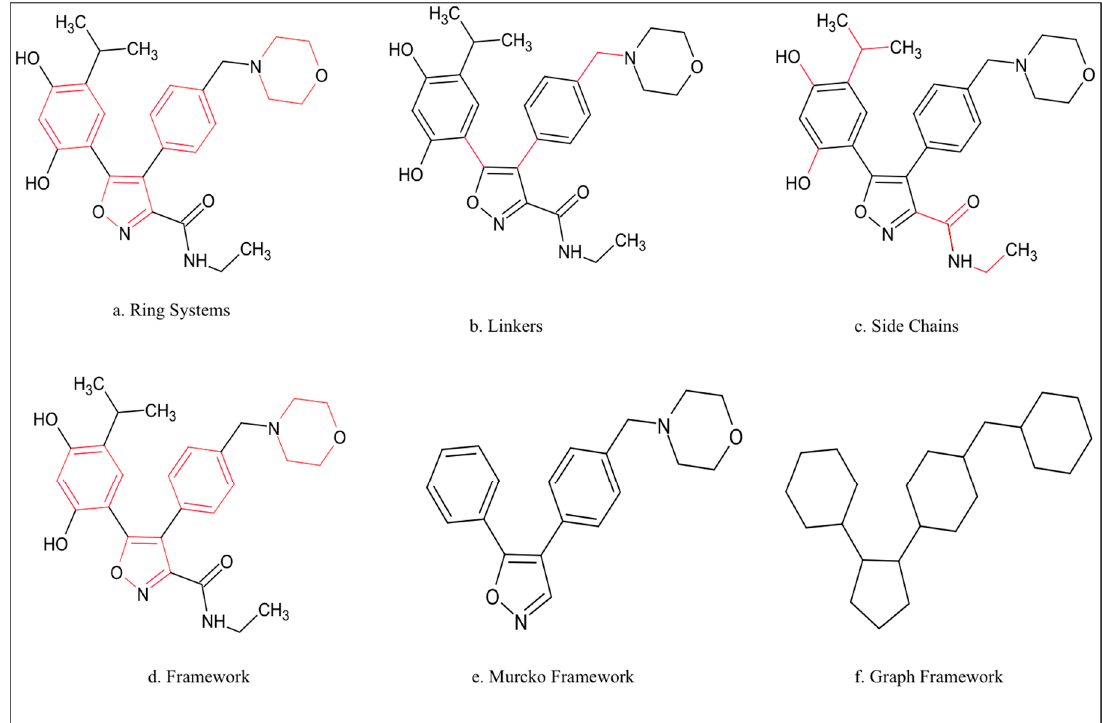
Figure 1. The framework representations of an exemplar molecular structure.